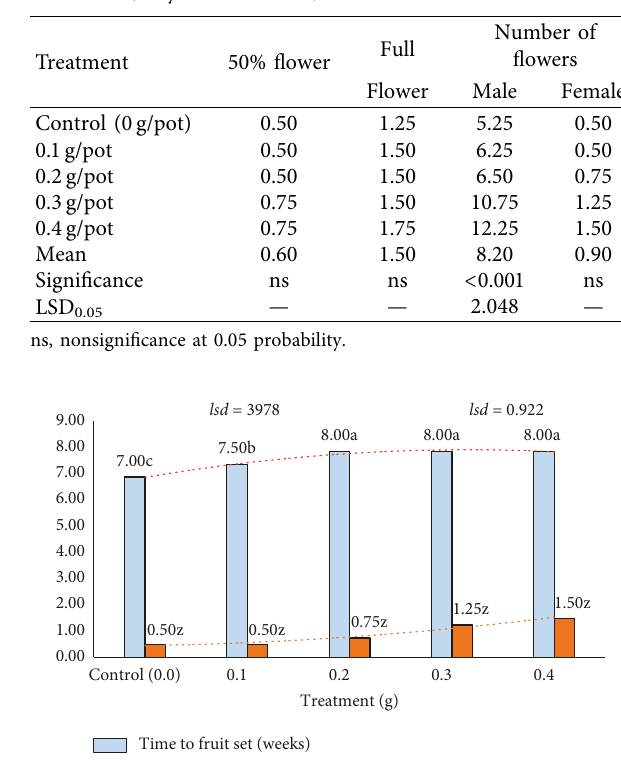
Figure 2: Influence of Trichoderma -based biofertilizer on days to fruiting and number of fruits. Figures not sharing a common letter in a column differ significantly at 0.05 probability.